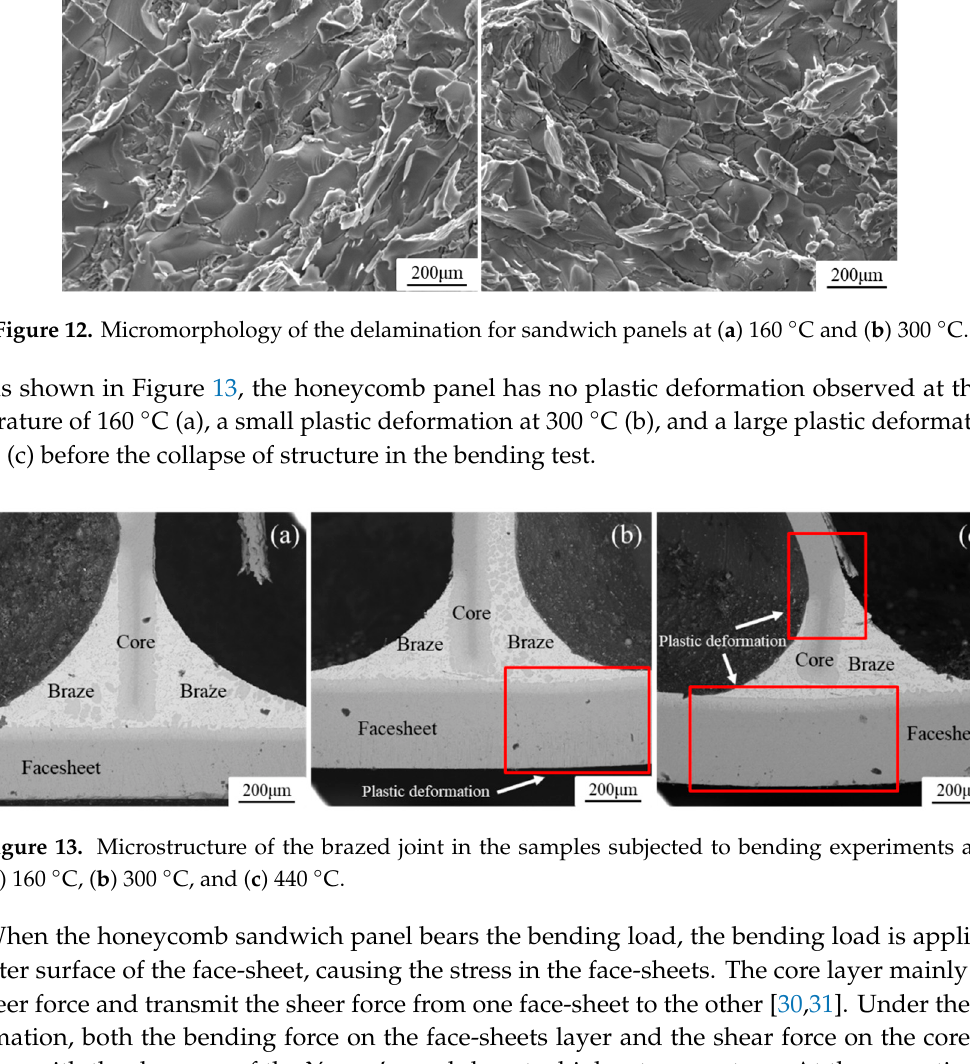
Figure 11. Micromorphology of the damaged W-direction sandwich panels at 20 °C: ( a ) the brazing joint region; ( b ) the magnified brazing region between the core and the brazing filler.